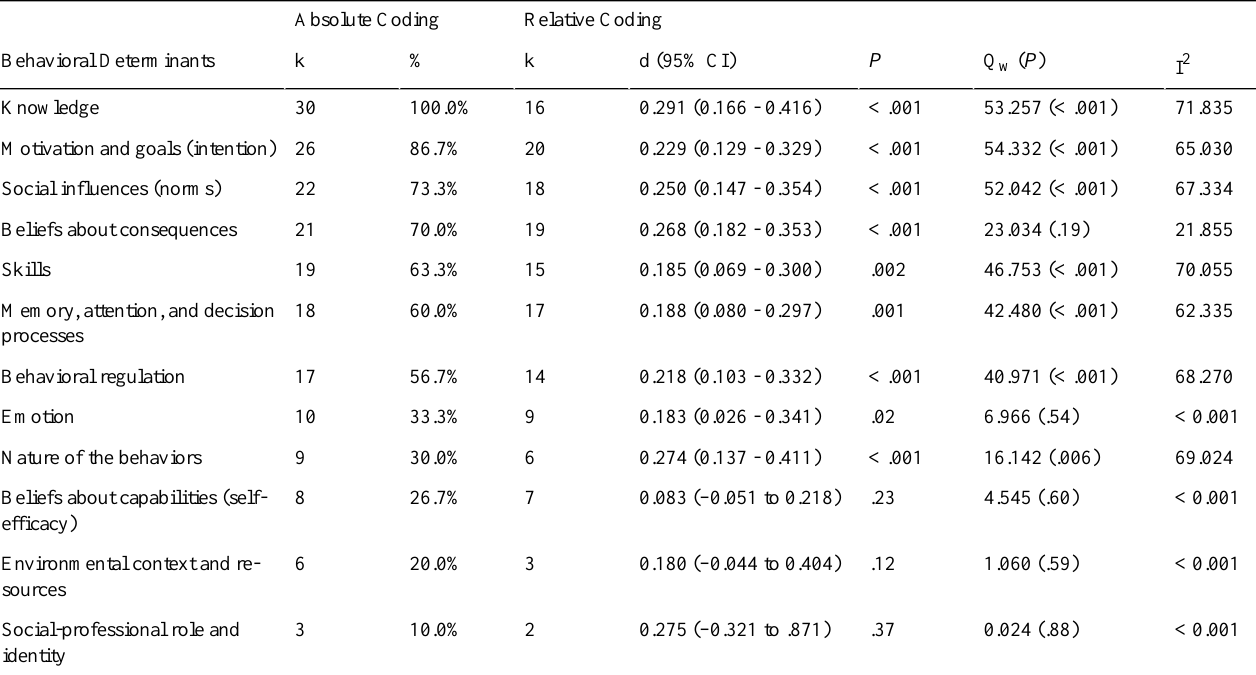
Table 8. Audience interpreter (behavioral determinants)